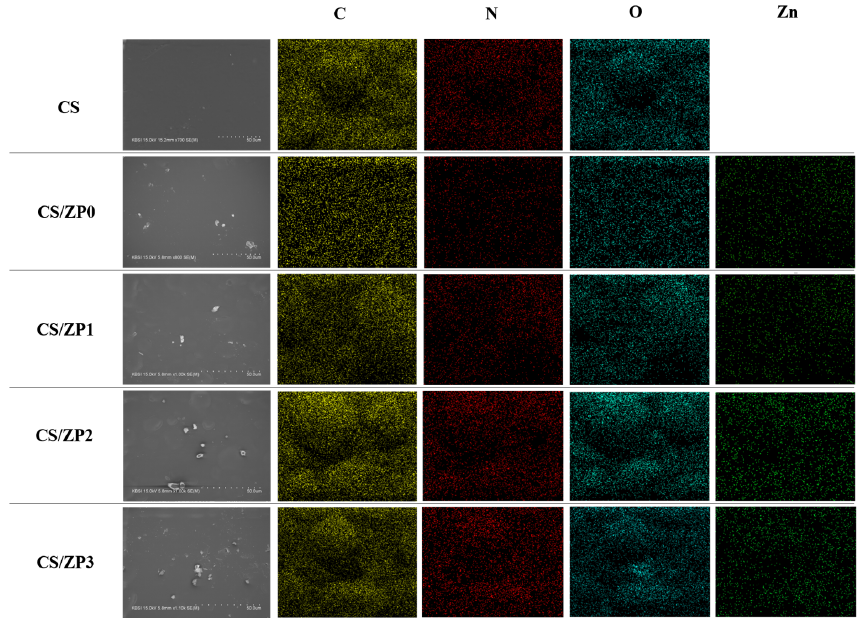
Figure 4. FE-SEM with EDS mapping image of neat corn starch (CS) film and bionanocomposite film